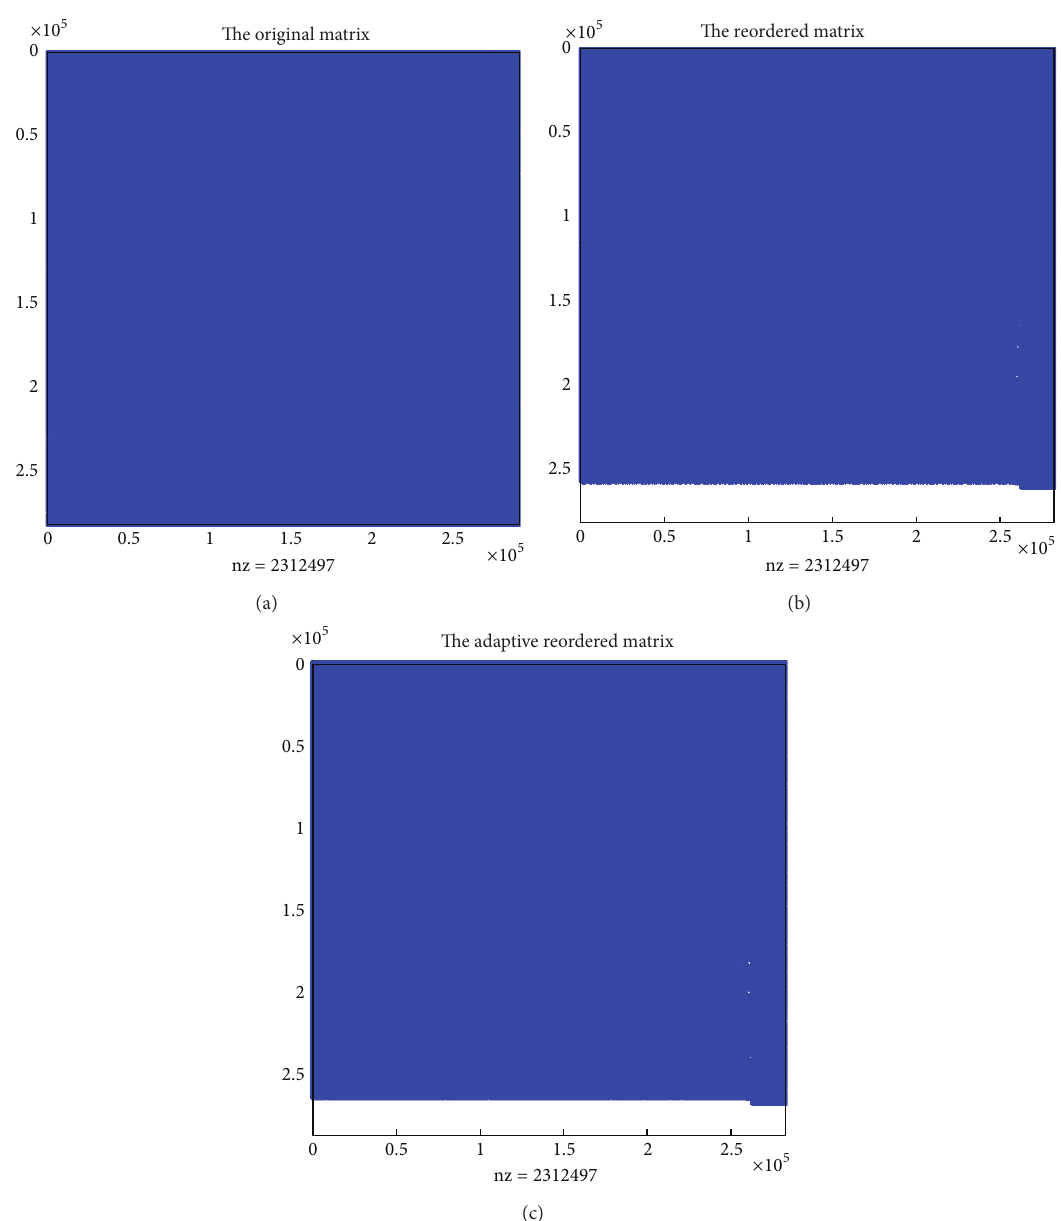
Figure 2: The resulted image of the original Stanford.mat (a) and matrices reordered using RD and aRD ((b) and (c)).